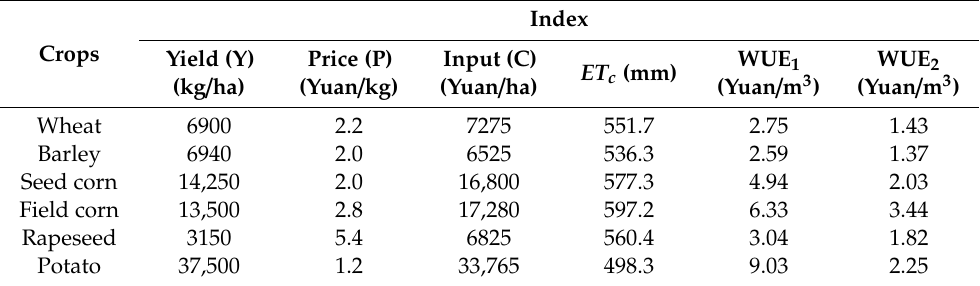
Table 5. Water-use efficiency (WUE) of the main crops in the study area.